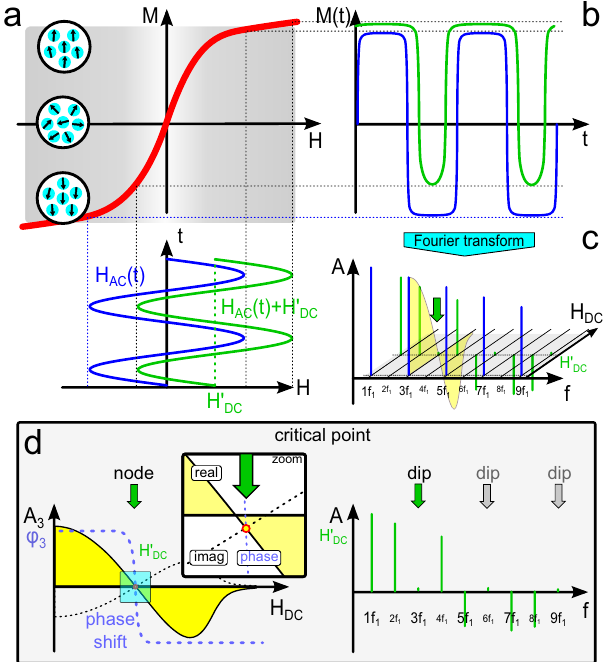
Fig. 2 | Origin of the critical point. a , b The behavior of the magnetization M of MNPs in dependency of external magnetic fi elds H can be described by the non- linear Langevin function (red curve). Exposing an MNP ensemble to a sinusoidal magnetic fi eld H AC ( t )withfrequency f 1 andsuf fi cientamplitude,themagnetization response M ( t ) consists not only of the fundamental frequency but also odd (and even)higherharmonics ( f n = n · f 1 )depending on thepresenceof anoffsetmagnetic fi eld H DC , which can be visualized in the Fourier spectrum. c Visualizing the dependency of the harmonic A n for the n -th higher harmonic for increasing offset magnetic fi eld H DC (with H DC < H AC ).The speci fi c shape forvarying H DC with nodes (green arrow) depends on the harmonic number n . As an example, the real part of